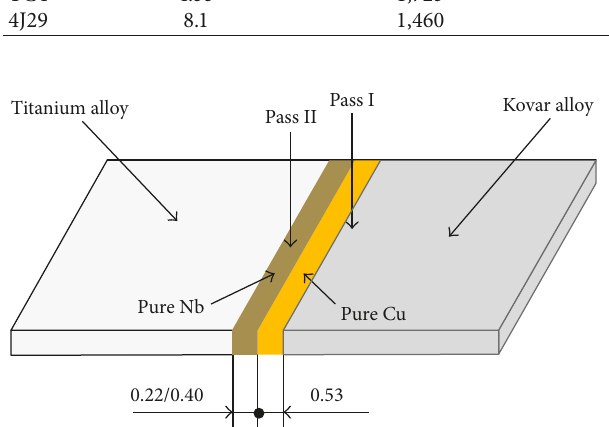
Figure 1: Schematic experimental conditions of dual-pass welding